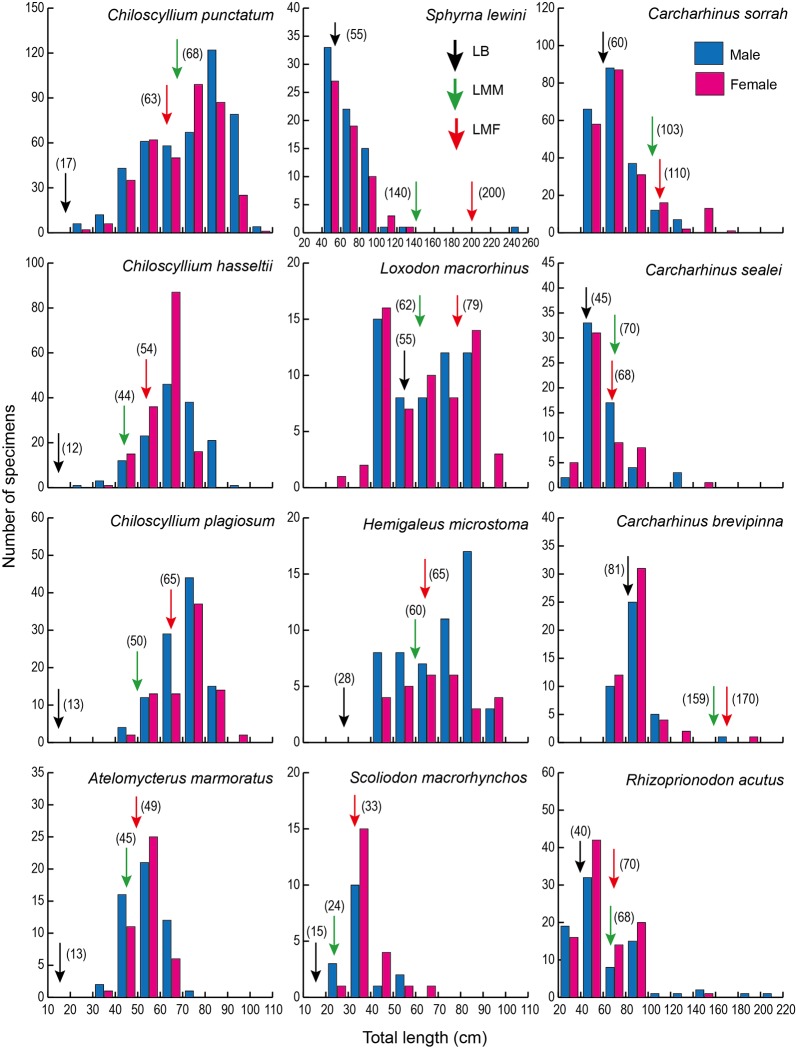
Size distributions of sharks landed in the southern South China Sea.Twelve shark species with more than 20 specimens landed at various growth stages from newborn juveniles and/or to mature adults22-26. LB (black arrow), LMM (green arrow) and LMF (red arrow) indicate the length at birth, length at maturation of male and length at maturation of female, respectively.